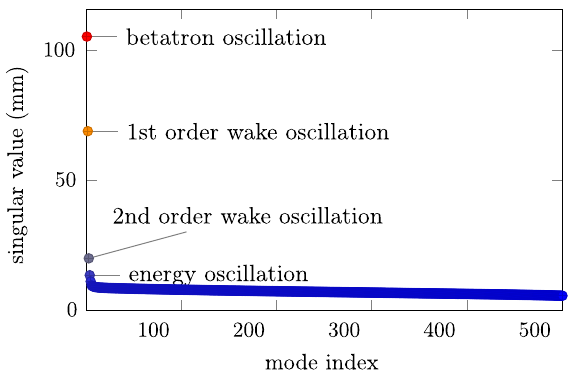
FIG. 5. Singular values of the separated modes. The noise floor is about 7.3 mm and the signal-to-noise ratio of the betatron oscillation is about 11.6 dB.